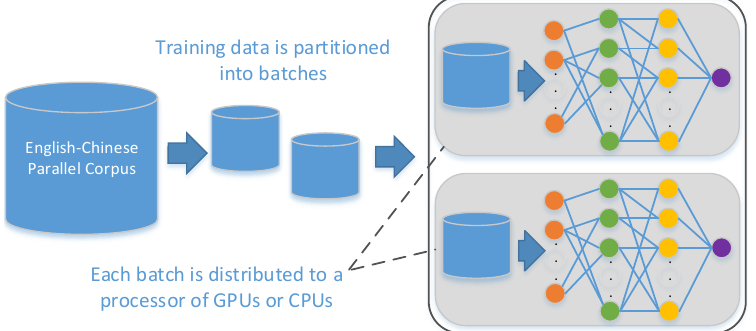
Figure 5. Data parallelism for training the transformer